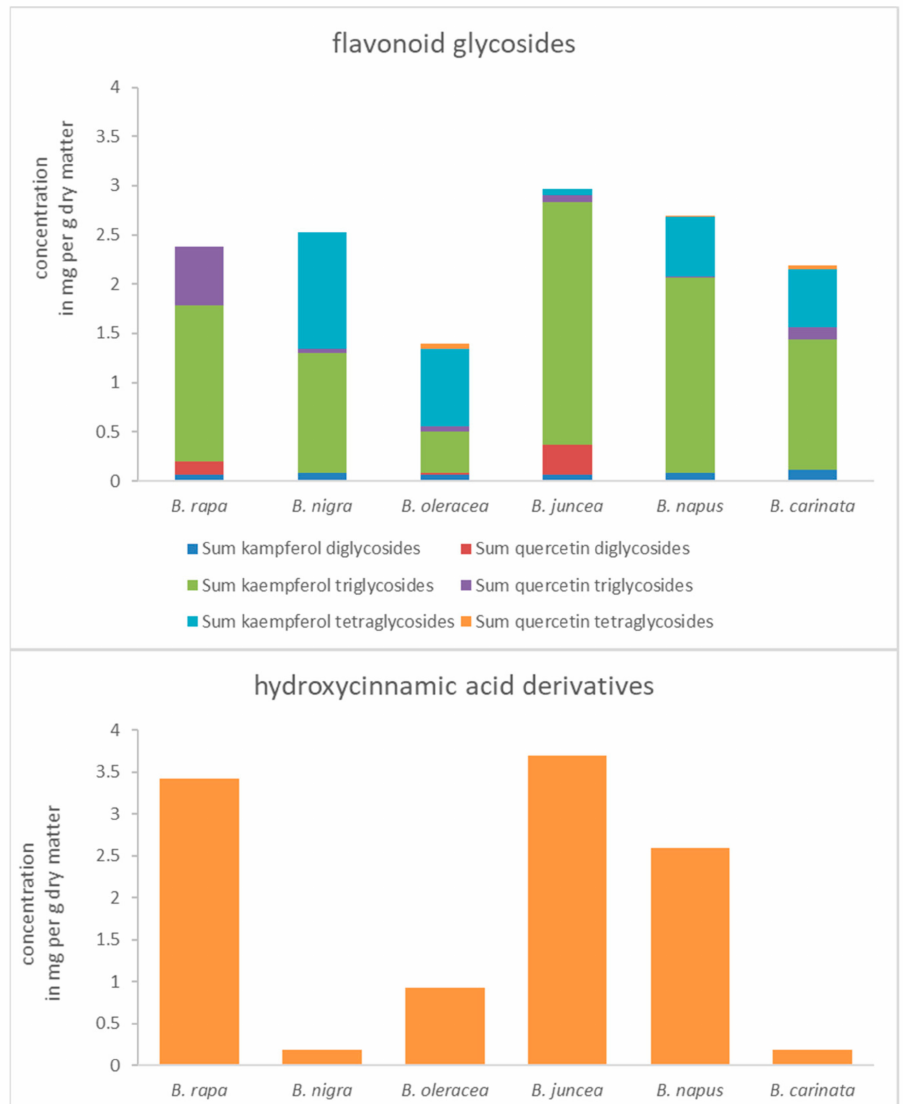
Figure 1. Concentration of flavonoid glycoside groups (separated on the type of aglycone and the glycosylation pattern) and hydroxycinnamic acid derivatives of related Brassica species (mean of all control plants) in mg per g dry